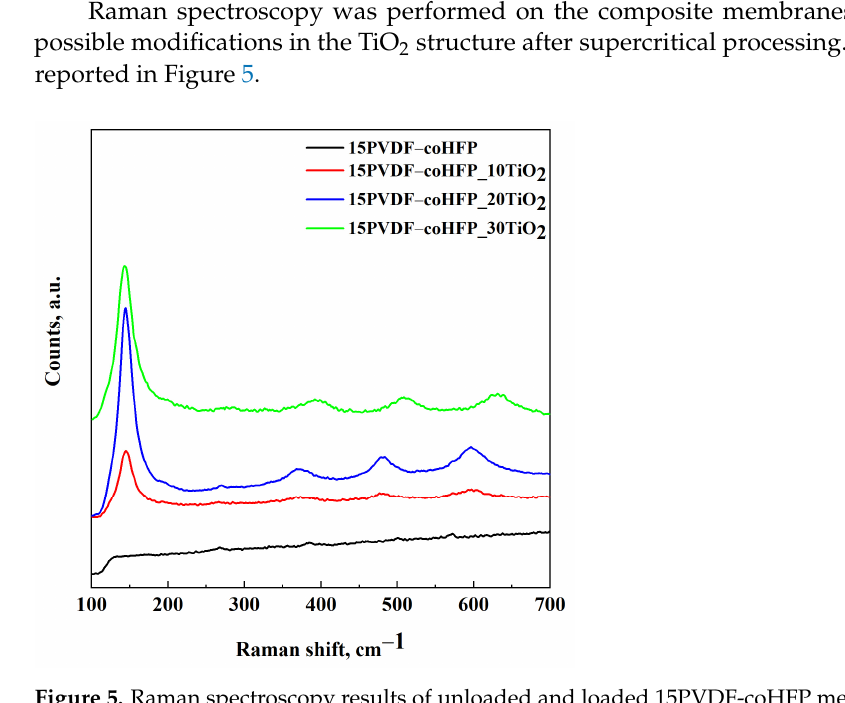
Figure 5. Raman spectroscopy results of unloaded and loaded 15PVDF-coHFP